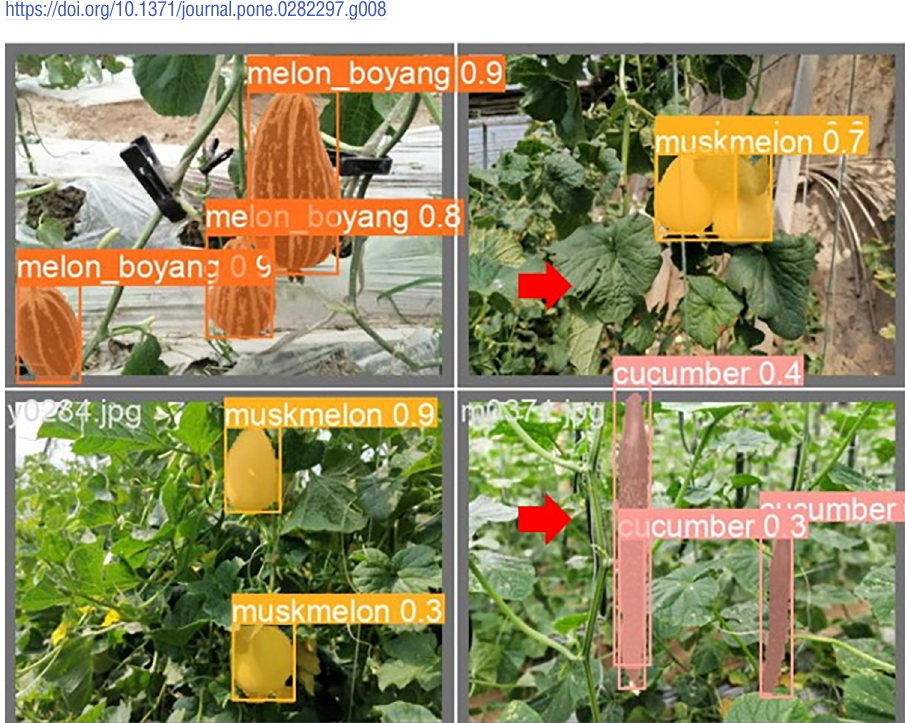
Fig 9. Image results of